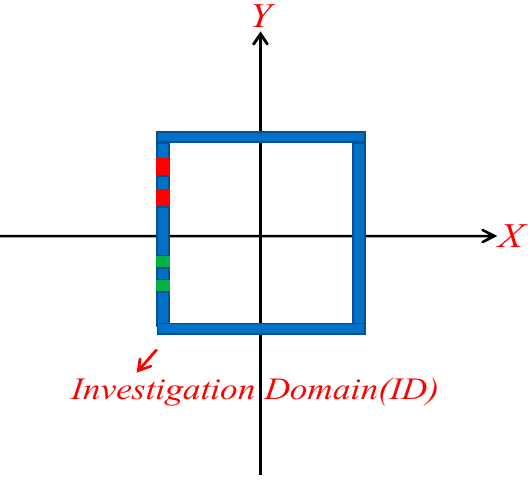
Figure 14. The geometry of the dielectric object (blue) with cracks (red and green).